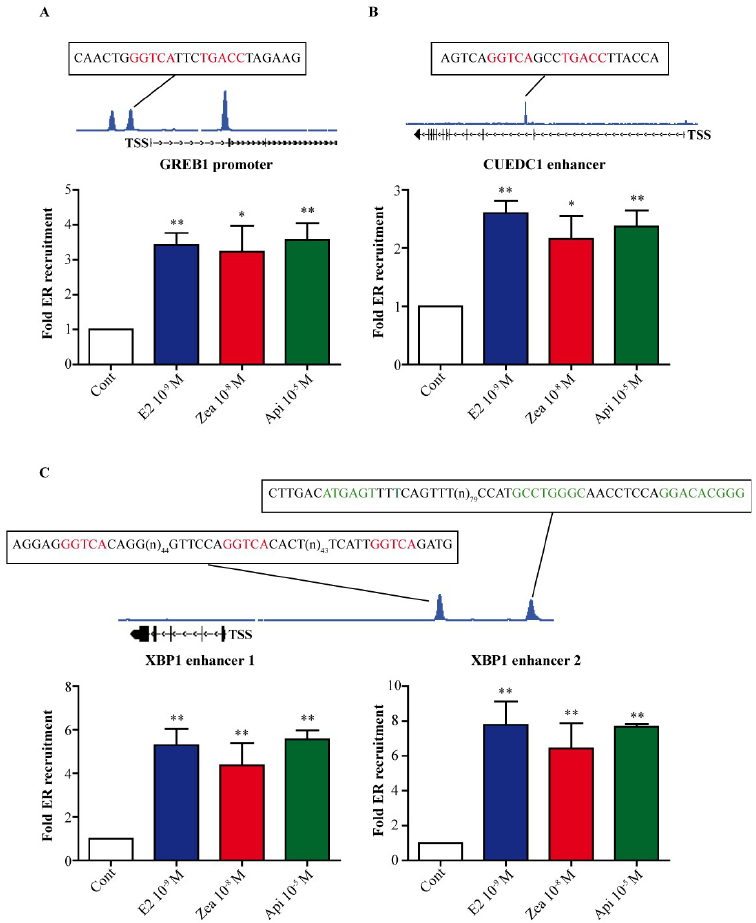
Figure 2. ERα recruitment to chromatin at distinct ER binding sites in response to E2, zearalenone and apigenin. MCF-7 cells were treated with solvent (white) as a negative control, 10 −9 M E2 (blue) as a positive control, 10 −8 M zearalenone (red) or 10 −5 M apigenin (green) for 1 h. The recruitment of ERα to the GREB1 promoter ( A ), CUE domain containing 1 (CUEDC1) enhancer ( B ) and the two enhancers of x-box protein 1 (XBP1) ( C ) was assessed by chromatin immunoprecipitation followed by real-time PCR. For each binding site tested, the DNA sequence is indicated. The results are expressed in fold recruitment compared to control and are the means of four independent experiments. * indicates a p -value < 0.05 and ** indicates a p -value < 0.01 by one-way ANOVA followed by Dunnett’s post hoc test for comparison of the control treatment with the other